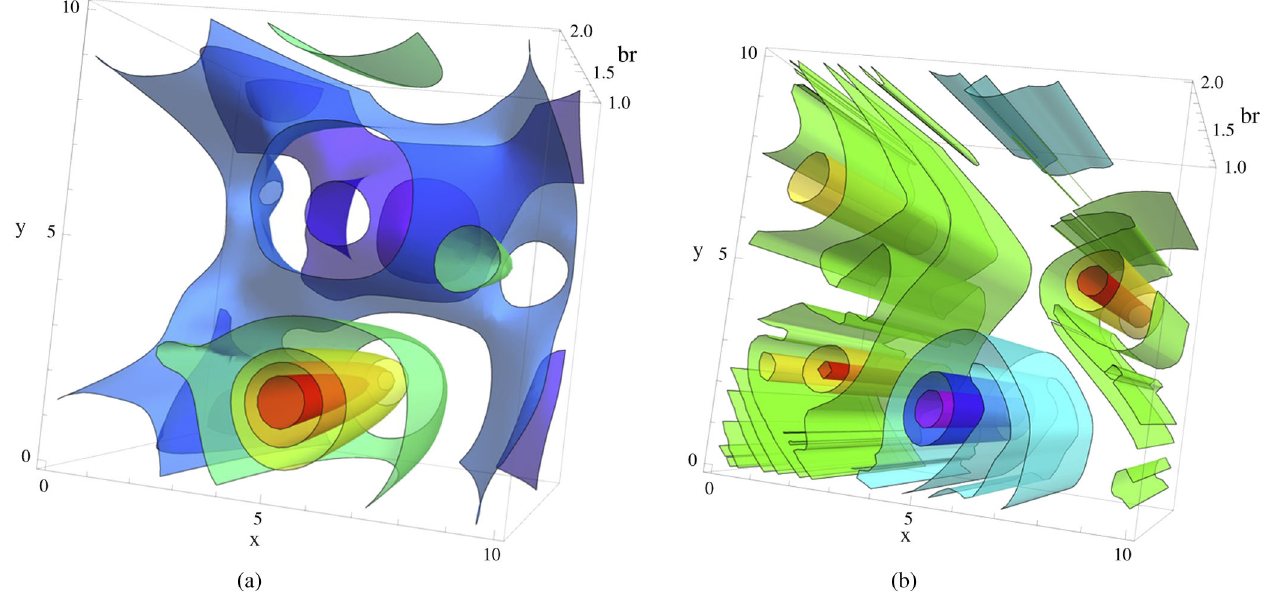
FIG. 8. Contour plots of principal invariants of the Weyl tensor in the bulk (rescaled with suitable powers of r as per Appendix B), computed from the zeroth-order metric (2.1), from the simulation snapshot in Fig. 1(e). Notice that (a) is representative of the energy density (cid:1) , while (b) is representative of the vorticity, as expected from Eq.